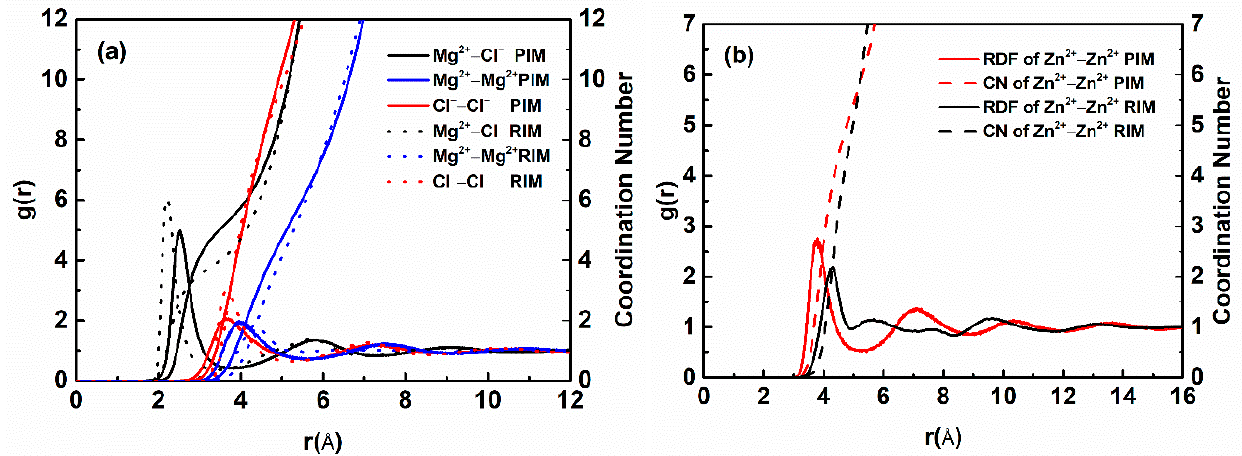
Figure 3. Simulated RDF and CN of molten chloride salts in PIM and RIM: ( a ) MgCl 2 at 1000 K; ( b ) ZnCl 2 at 600 K. Table 5. First peak positions of cation–cation for molten chloride salts.